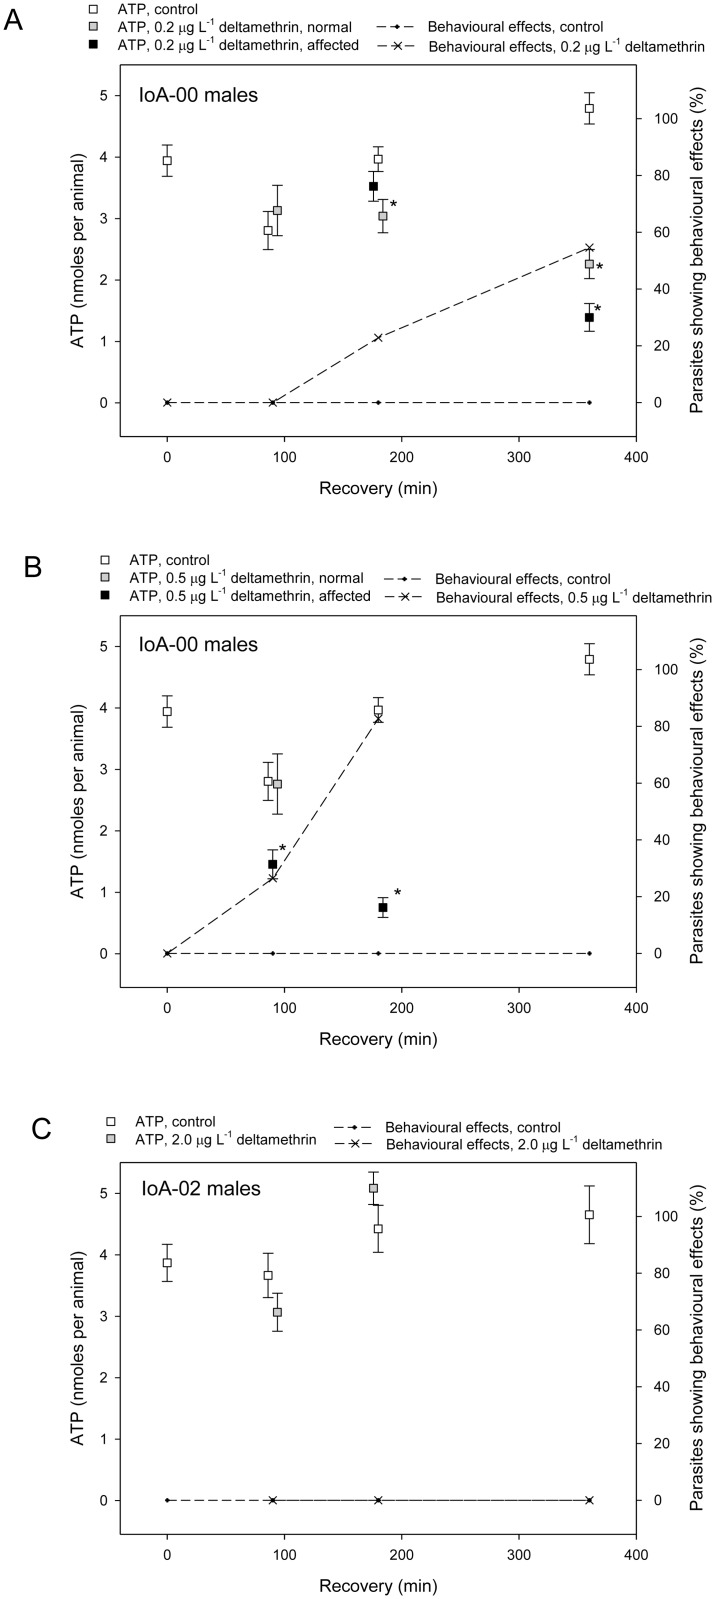
Effects of deltamethrin on ATP levels in L. salmonis.Male adult L. salmonis were exposed to deltamethrin or solvent PEG300 (0.05% v/v, controls) for 30 min and then allowed to recover in seawater. At different time periods during recovery, behavioural effects were recorded and animals were sampled for determination of whole body levels of ATP. See the legend of Fig. 4 for more details and explanation of symbols. A, Effects of 0.2 μg L-1 deltamethrin on IoA-00 parasites. B, Effects of 0.5 μg L-1 deltamethrin on IoA-00 parasites. C. Effects of 2.0 μg L-1 deltamethrin on IoA-02 parasites.